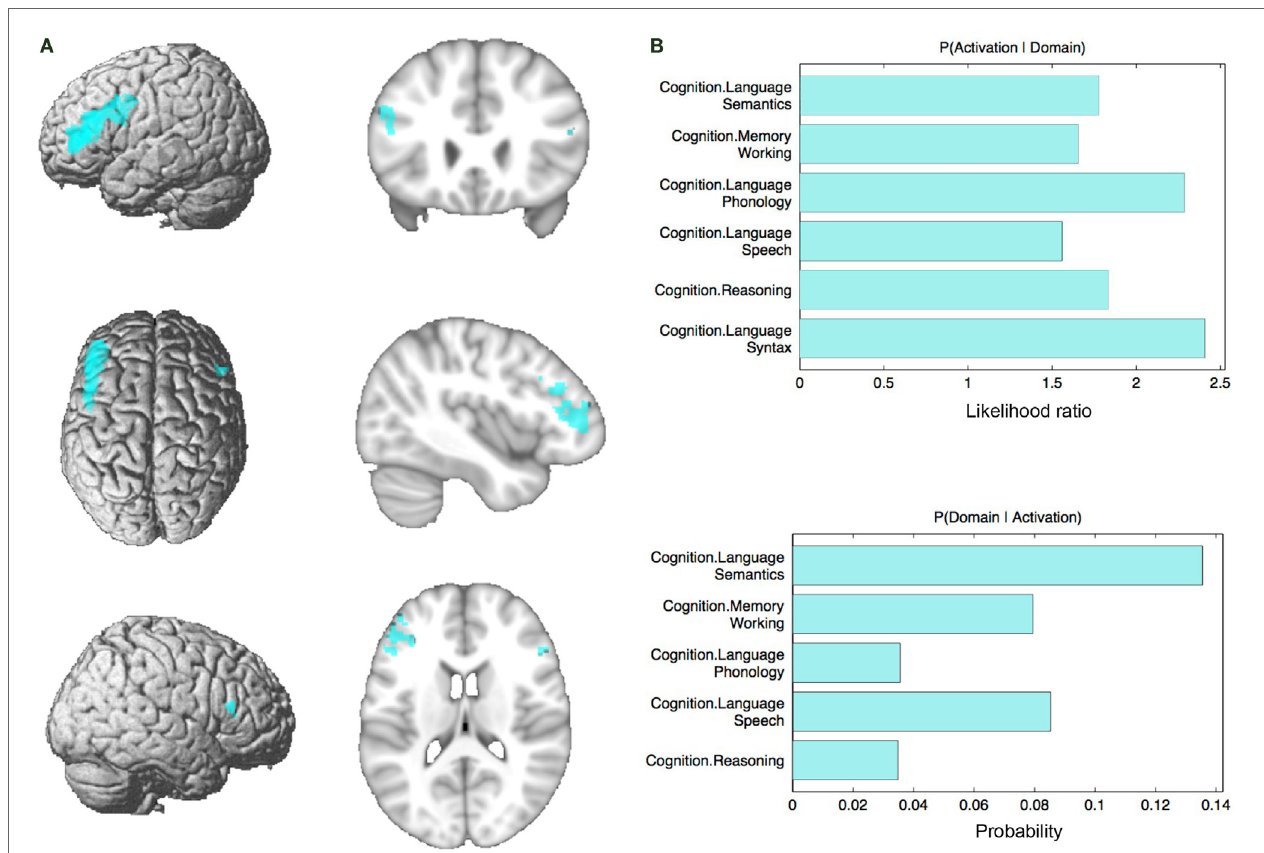
FigUre 5 | conjunction analysis and functional characterization of seed . (a) Conjunction across RS-FC, MACM, SC, and PT. (B) Behavioral domains from the BrainMap database significantly associated with the commonly connected regions shown in (a) (FDR-corrected for multiple comparisons, p < 0.05).